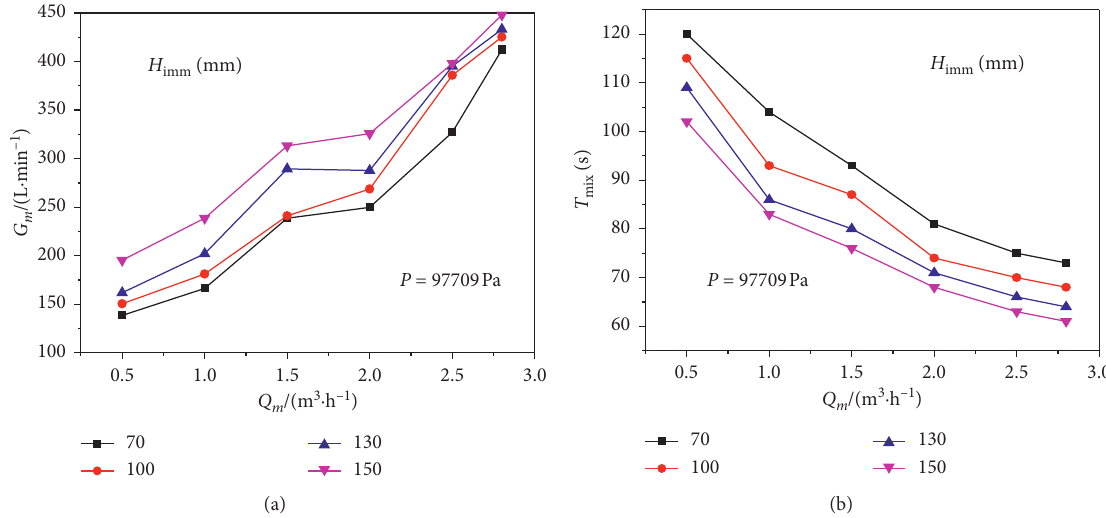
Figure 9: Effect of Q m and H imm on the G m and T mix of RH with arched snorkels.